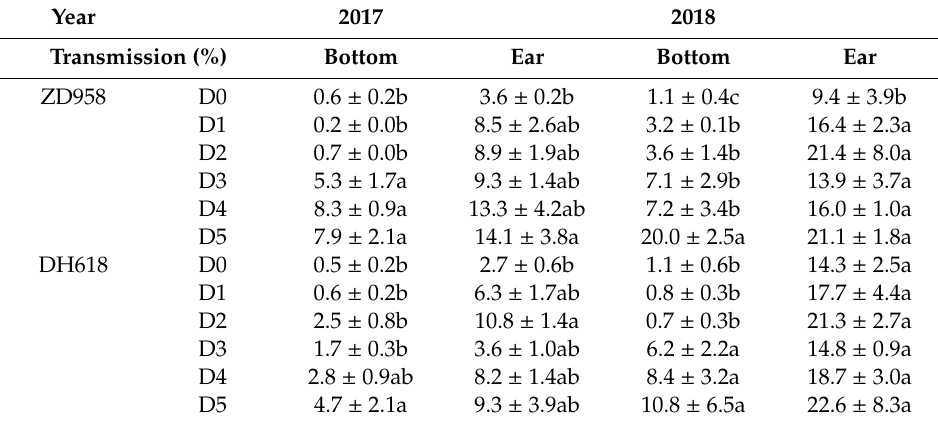
Table 3. Light transmission measured at the lowest green leaves and at the ears of cultivars ZD958 and DH618 under di ff erent treatments in 2017 and 2018.